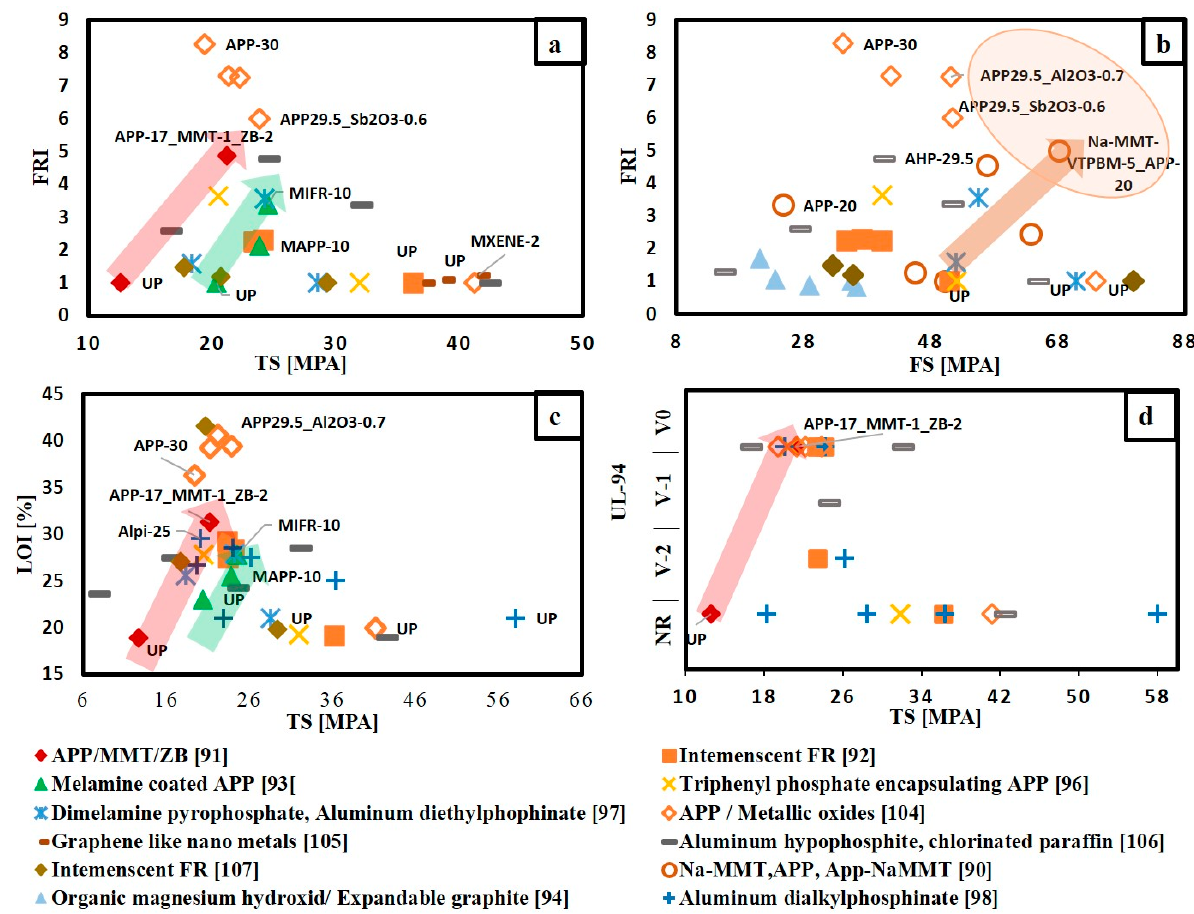
Figure 6. Selection chart of FR type regarding the desired flame retardance level and the mechanical property for unsaturated polyester resin. ( a ) FRI versus TS; ( b ) FRI versus FS; ( c ) LOI% versus TS; ( d ) UL-94 versus TS.